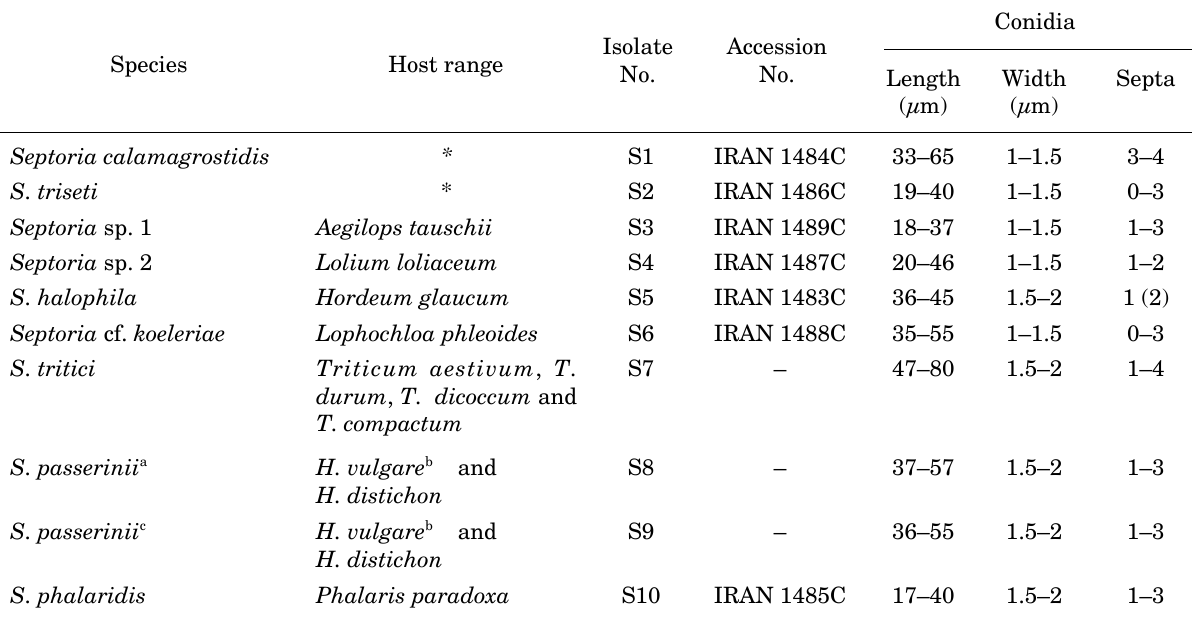
Table 3. Host range, deposit number and morphological characteristics of Septoria